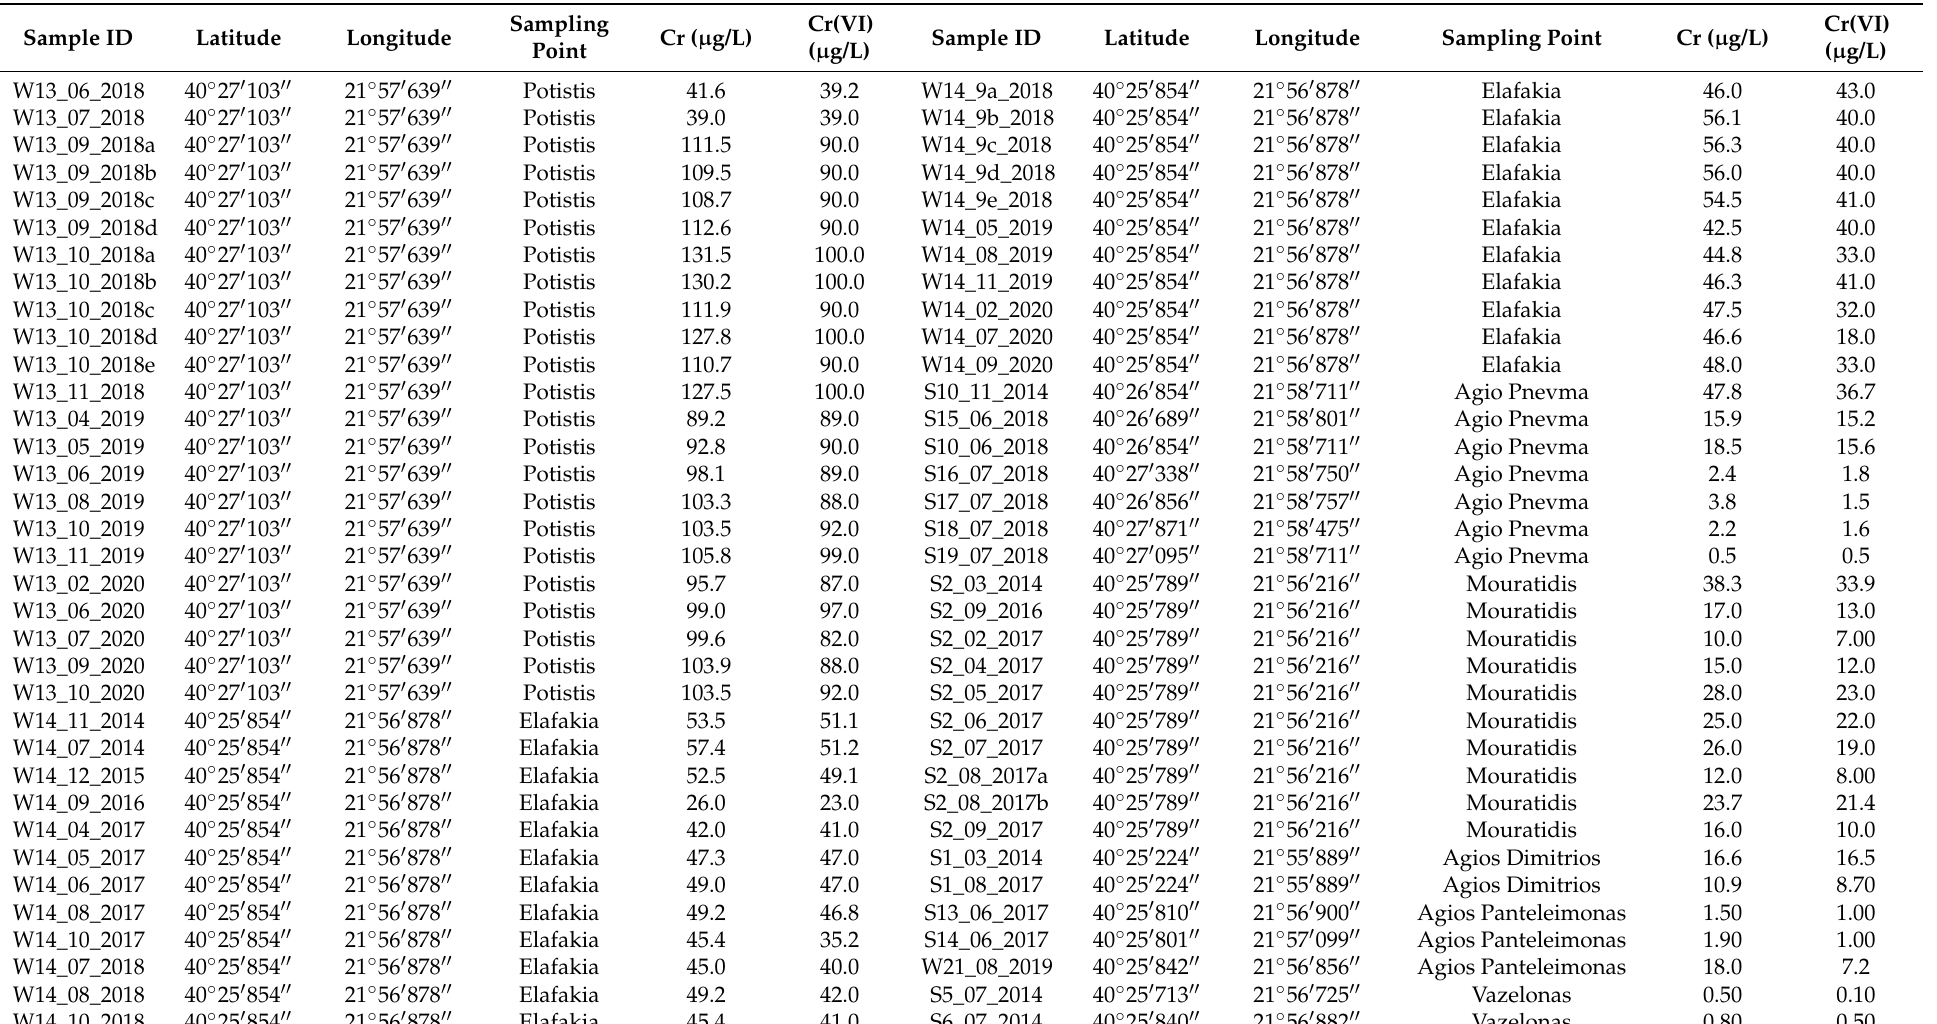
Table 3. Geographical coordinates of the water sampling sites and the results of Cr-Cr(VI) for the natural springs in western Vermio